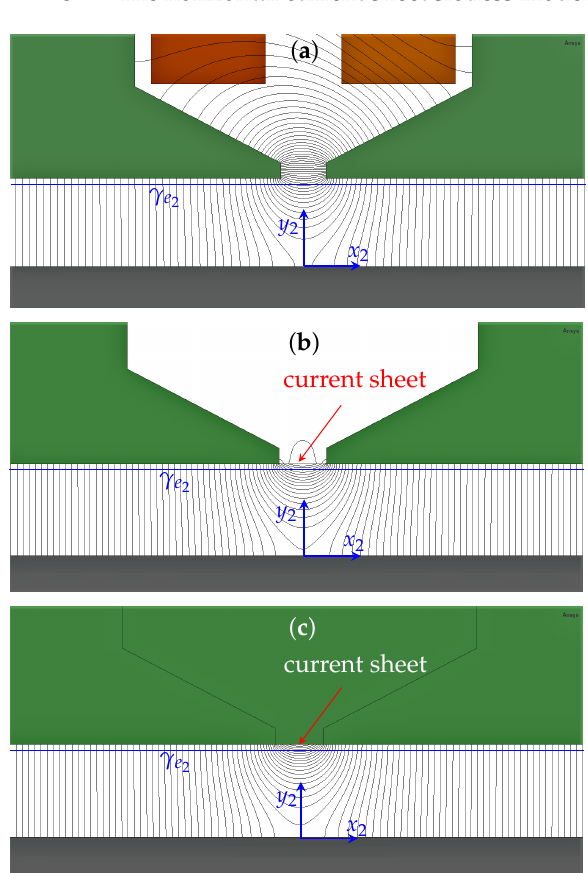
Figure 9. Flux lines produced by three different case studies: ( a ) 1. two phase active sides whose total m.m.f. value is M s ( b so = 6 mm); ( b ) 2. horizontal current sheet of length b cs = b so = 6 mm powered by a current I = M s inside a slotted geometry; ( c ) 3. horizontal current sheet of length b cs = b so = 6mm inside a slotless